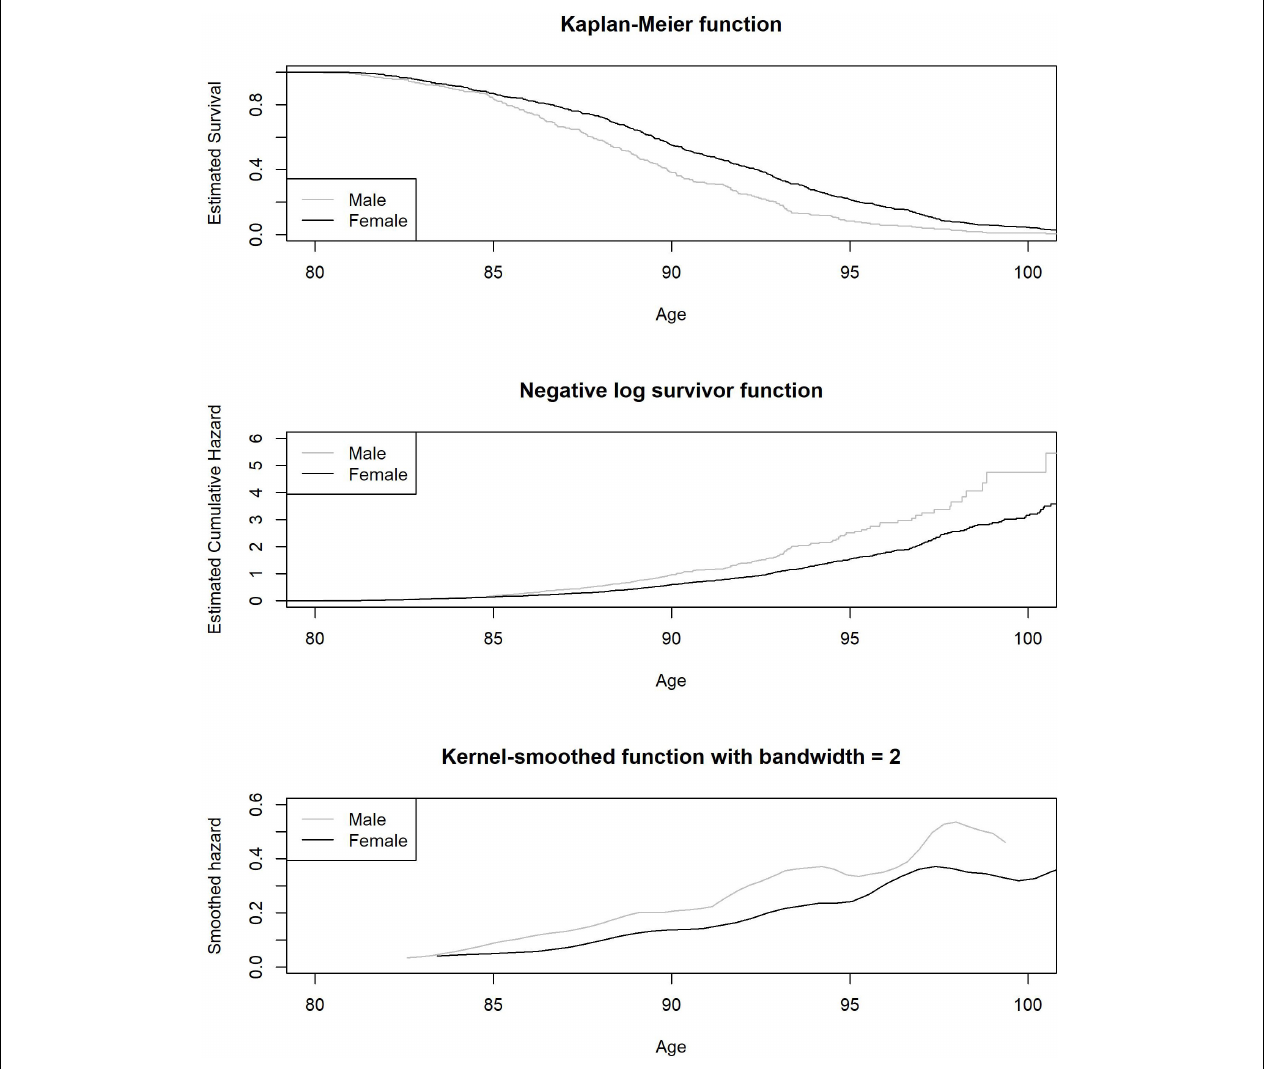
FIGURE 3 | Estimated Kaplan-Meier survival function, negative logarithm of the